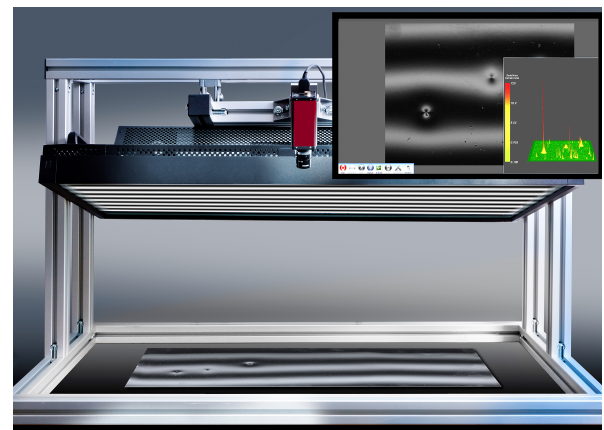
Figure 19. Setup used to measure the measurement uncertainty of the deflectometric sensor for different frequencies of the fringe pat- tern on the surface.